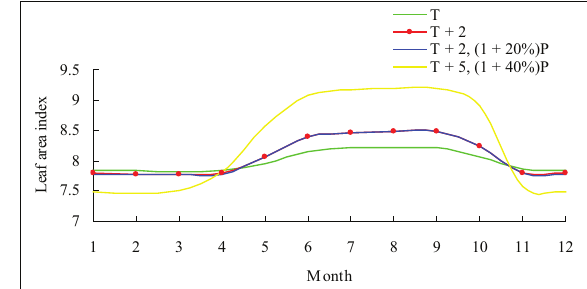
Figure 7. Five-year mean monthly evapotranspiration during the three periods: (a) T run; (b) (T+2) run; (c) [T+2, (1+20%)P] run; and (d) [T+5, (1+40%)P] run